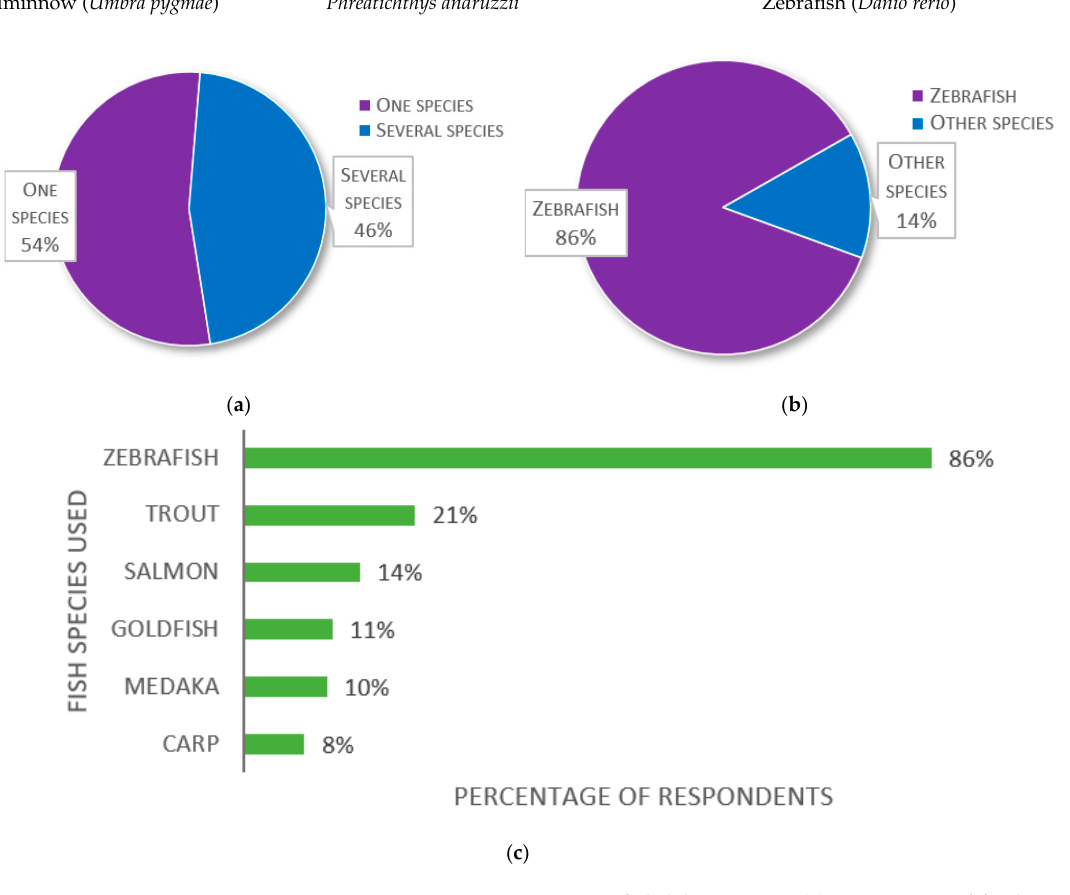
Figure 2. Species composition in survey fish laboratories: ( a ) Proportion of facilities conducting research on either one or two or more species ( n = 145); ( b ) Proportion of facilities conducting zebrafish ( Danio rerio ) research against facilities using only other species ( n = 145); ( c ) The most commonly used species amongst the 145 respondents and the percentage of facilities that use them.